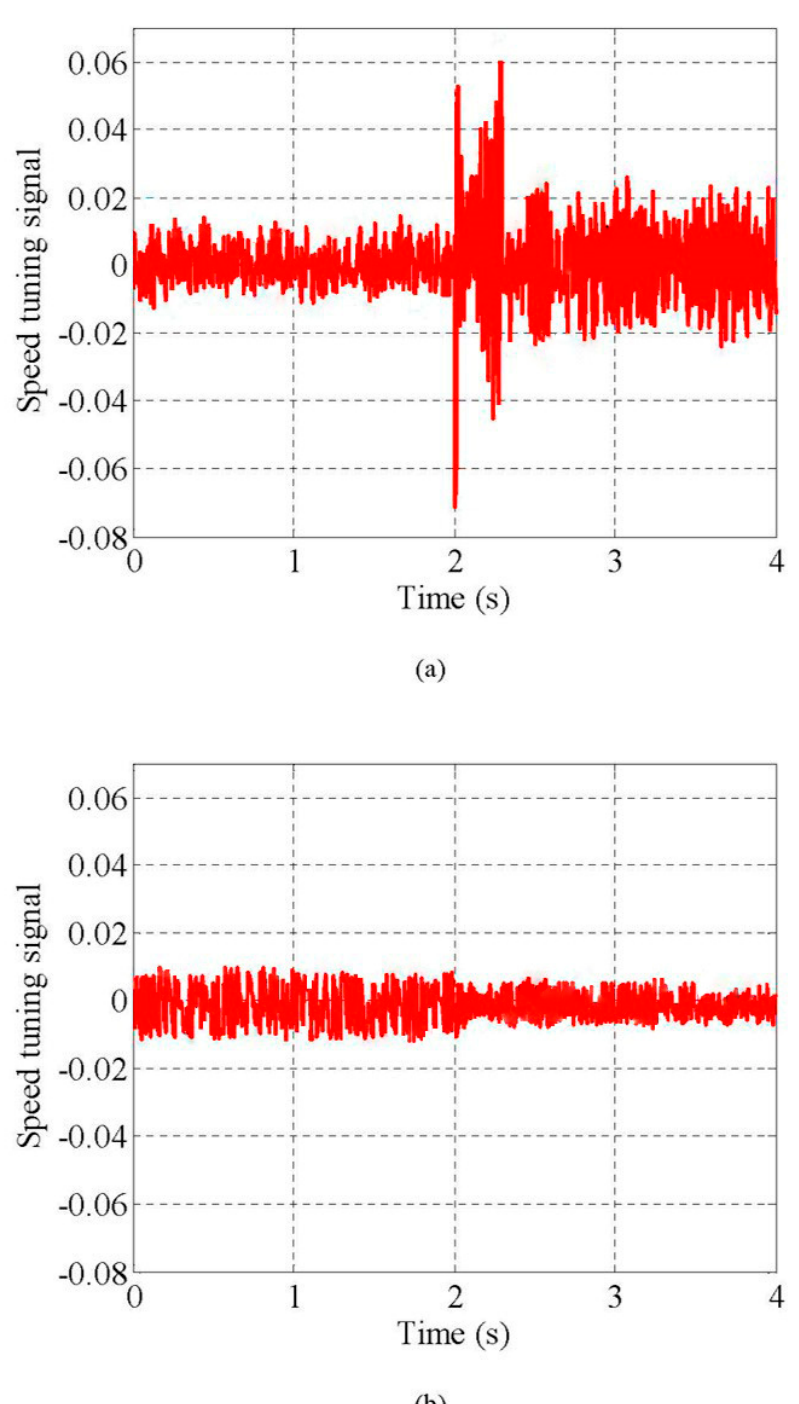
Figure 15. Speed-tuning signal under the reference speed change from 40 to 100 rpm at full load. ( a ) MRAS control method. ( b ) Proposed MPC-MRAS control method.